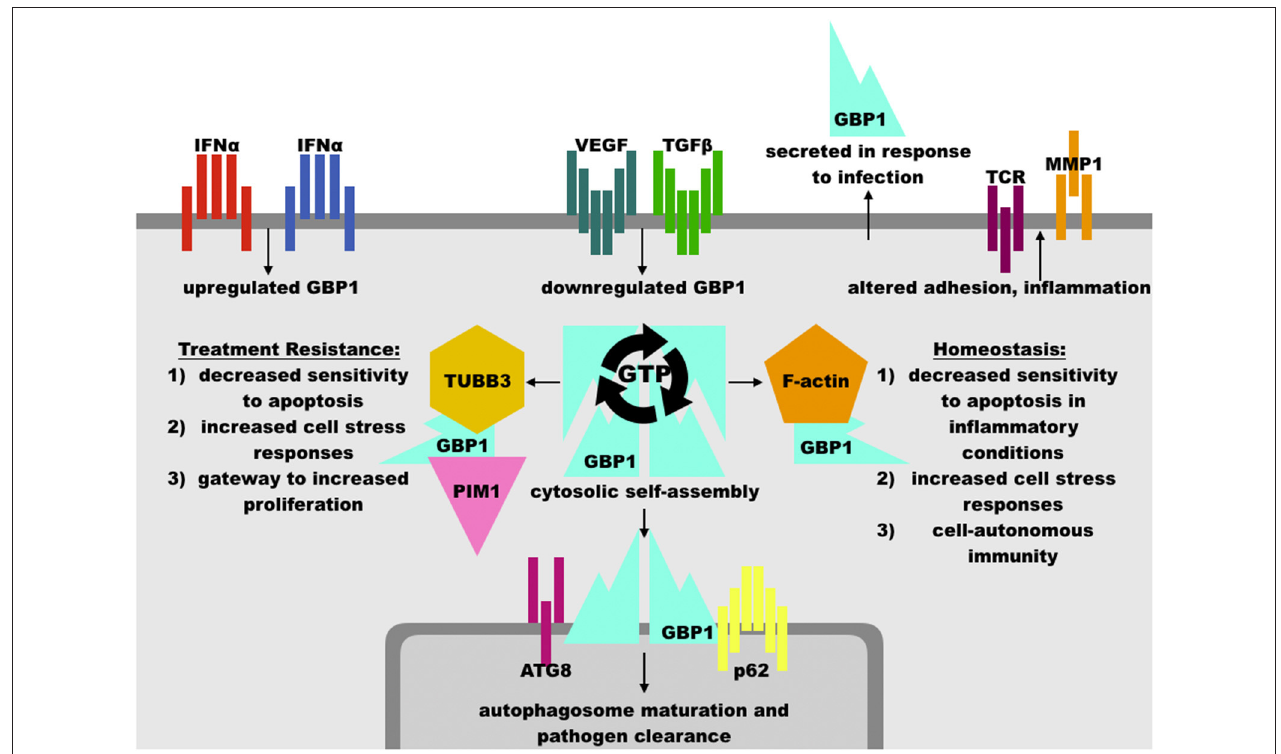
FIGURE 2 | Overview of GBP1 function. GBP1 may be upregulated in response to interferons or other inflammatory cytokines, such as TNF α , and is downregulated by growth factors such as vascular endothelial growth factor (VEGF) and transforming growth factor β (TGF β ). GBP1 may localize cytosolically, at membrane surfaces, or extracellularly via secretion. GBP1 self-assembly and binding partner accessibility are regulated by its GTP binding status, where GTP favors assembly while GDP inhibits it. GBP1 has been found in complex with TUBB3 ( β tubulin III), PIM1 (Pim-1 proto-oncogene, serine/threonine kinase), ATG8 (autophagy-related protein 8), p62 (sequestosome 1), F-actin monomers, and others, which facilitates its diverse cellular effects. These include an essential role in the clearance of intracellular pathogens, arrest of cell proliferation in inflammatory conditions, and protection of cells from inflammation-induced apoptosis. These activities may be hijacked by upstream oncogenic events to promote cancer cell survival against cytotoxic therapies, such as paclitaxel and radiation therapy. Other functions of GBP1, such as modulation of inflammatory state, its association with factors such as PIM1, and promotion of cell-cell adhesion dysregulation may serve to increase disease progression in diverse cancer sub-types, including ovarian, head-and-neck, and brain lesions. In human patients, mutations in GBP1 are associated with chronic viral infection, although mutation in GBP1 is not necessary for its involvement in treatment